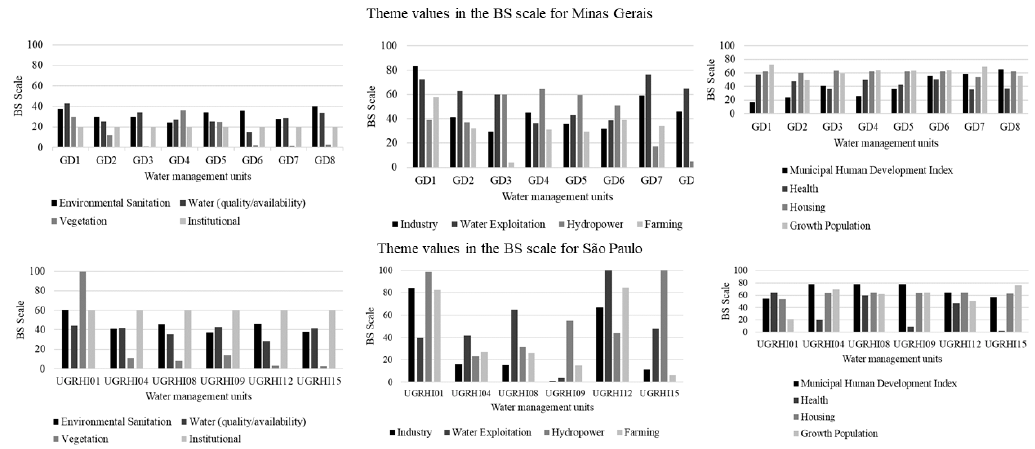
Figure 8. Theme values in the BS scale for the states of Minas Gerais and São Paulo.